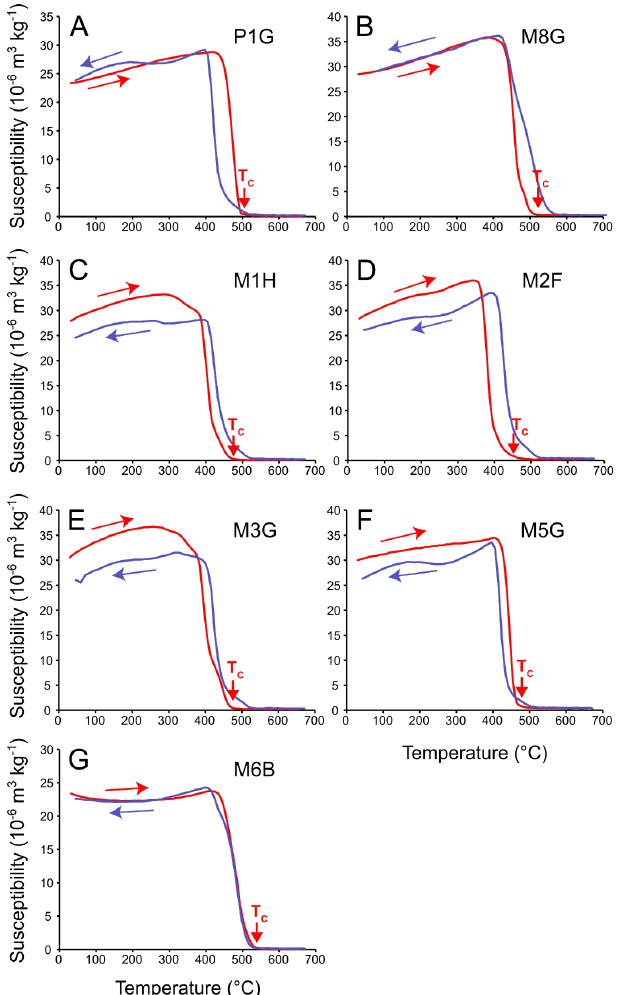
Figure 4: Temperature dependence of magnetic suscep- tibility of Maero block-and-ash flow deposit clast sam- ples. Curves from [A] to [G] represent units of decreas- ing age within the sequence. Red line represents heat- ing, blue line represents cooling. Curie temperature of magnetic minerals are shown by the red